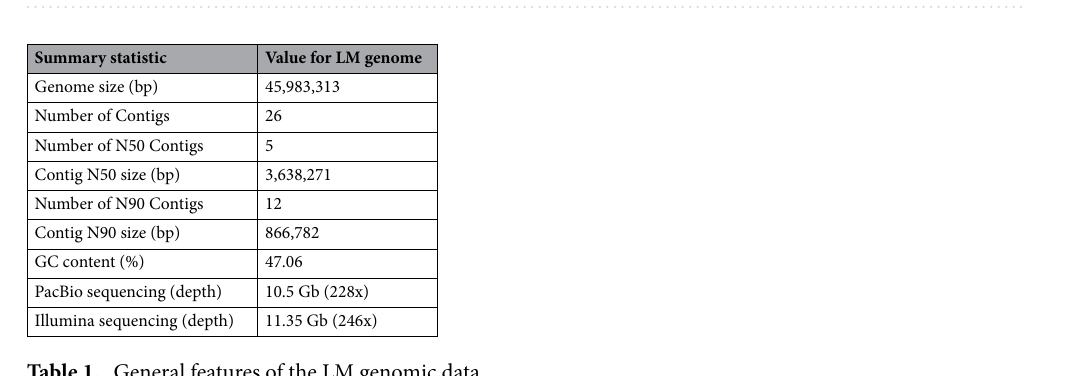
Figure 1. The fairy ring habit of LM in the Mongolian Plateau. The fruiting bodies grow on the outer edge of the ring.